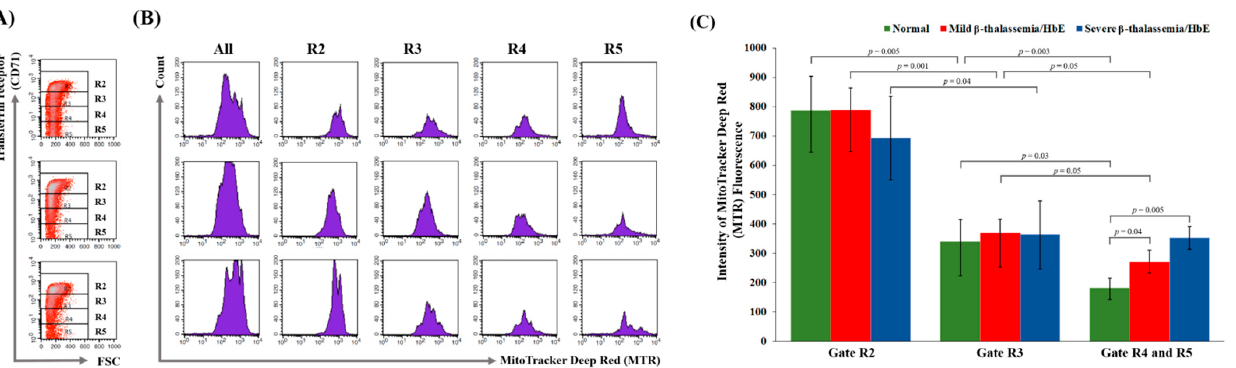
Figure 1. Flow cytometry analysis of in vitro culture erythroid cells at day 16. ( A ) Representative FACS plot of transferrin receptor (CD71) versus forward scatter (FSC) in erythroid cells’ culture of healthy normal control (upper panel), mild β 0 -thalassemia/HbE patient (middle panel) and severe β 0 -thalassemia/HbE patient (lower panel). The 10,000 cells per sample were analyzed (assigned as R1 population). The R2, R3, R4 and R5 cell populations were gated according to the fluorescent intensity of CD71. ( B ) Representative histogram plot of the MitoTracker Deep Red (MTR) stained erythrocytes from R1–R5 gates of healthy normal control (upper panel), mild β 0 -thalassemia/HbE patient (middle panel) and severe β 0 -thalassemia/HbE patient (lower panel). ( C ) Quantification of MTR fluorescence in healthy normal control (green bar), mild β 0 -thalassemia/HbE patient (red bar) and severe β 0 -thalassemia/HbE patient (blue bar), n = 3 in each group. Data are presented as mean ± SD. The two-tailed Student’s unpaired t -test was applied to compare the means between